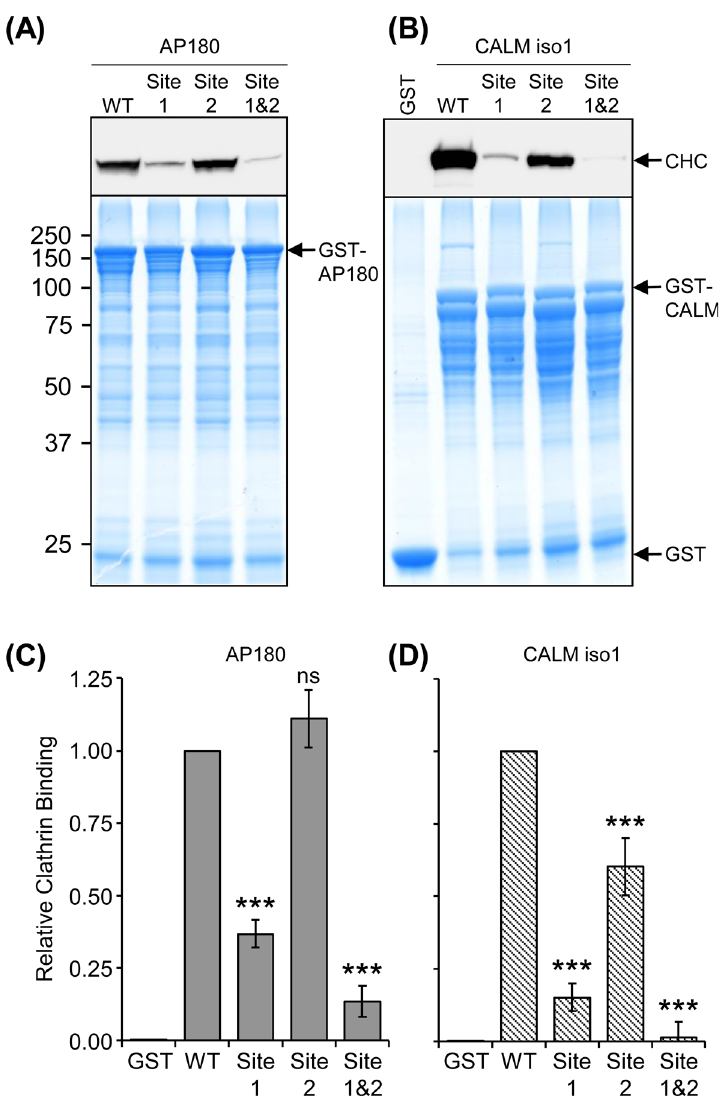
pull-downs with rat synaptosome lysate and the amount of clathrin bound was determined by Western blot with anti-clathrin heavy chain (CHC) using 40% of the sample (representative blot shown from two 1 h pull- down experiments). Ten percent of the sample was resolved by SDS-PAGE and stained with Coomassie for comparison of bait levels. The experiment was performed twice more, except the pull-down was for 10 min instead of 1 h and the result was very similar (Figure B in S1 File). (C) and (D) Comparison of clathrin binding from the combined densitometry of 10 min and 1 h pull-downs with the AP180 mutants normalised to AP180 WT and the CALM mutants to CALM WT. Data is expressed as average relative amount of clathrin bound as a fraction of the WT pull-down ± SEM ( n = 4; *** , P < 0.001 compared to WT; ns = not